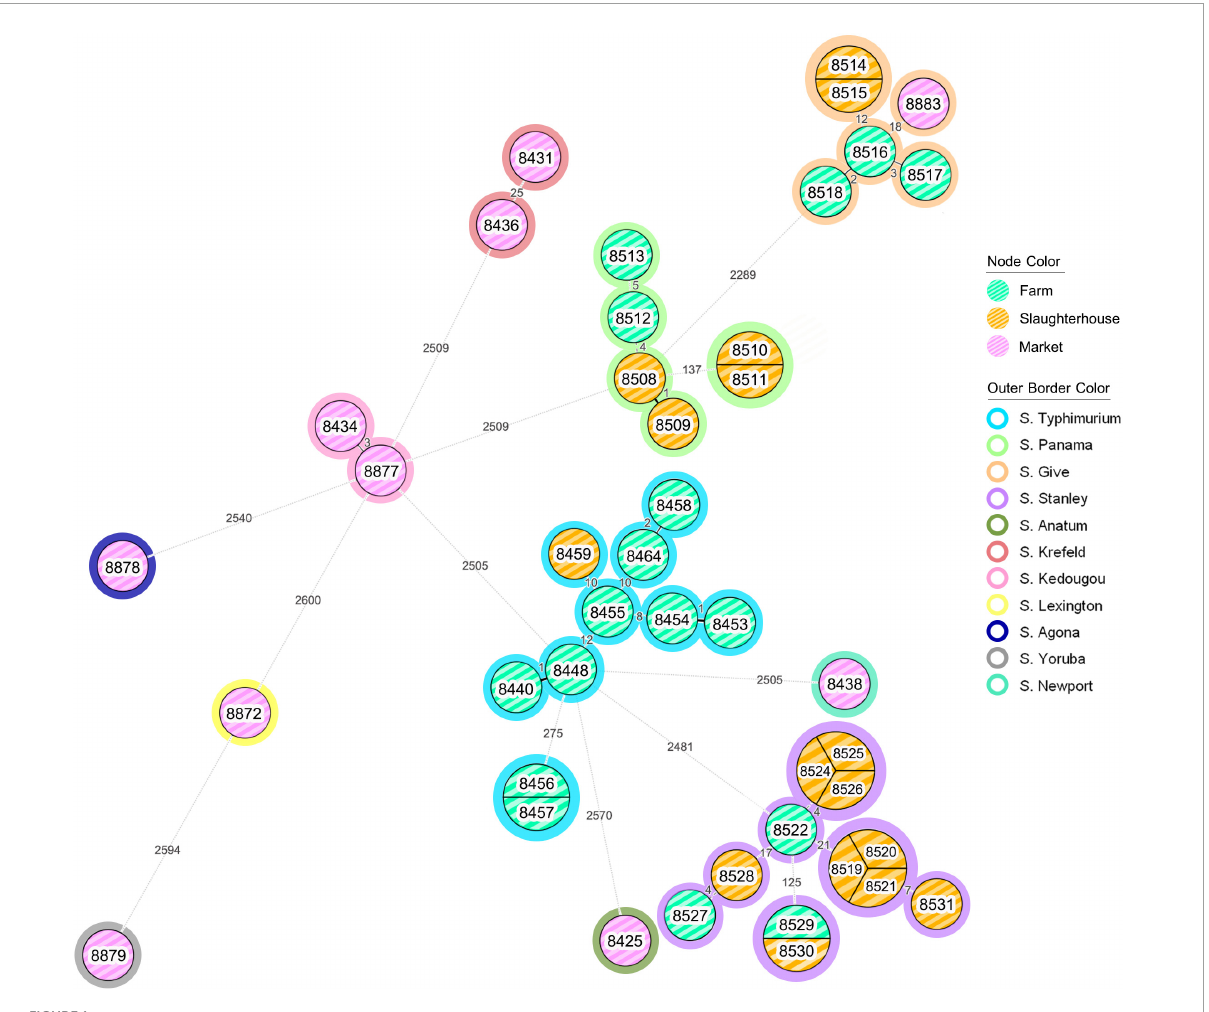
FIGURE1 The minimum spanning tree (MST) analysis of Salmonella isolates recovered from the pork production chain. Each isolate was grouped according to the loci different of EnteroBase Salmonella database’s cgMLST scheme, which considers a total of 3,002 loci (Pearce et al., 2020). The number on the branch represent the number of loci different between each isolate. Node color coding: green color, yellow color and pink color represent the Salmonella isolates recovered from farm, slaughterhouse and retail market, respectively. Outer border color represents each serotype of Salmonella